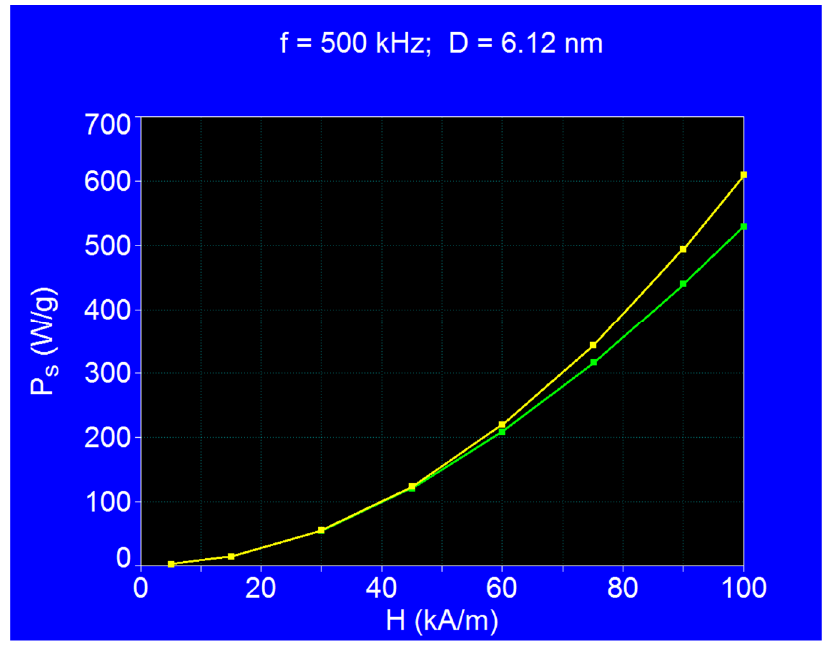
Figure 6. The dependence of the maximum specific loss power (P sM ) on the magnetic field (H) for CoFe 2 O 4 nanoparticles, calculated at the frequency (f) of 500 kHz using Equation (7) (yellow curve) and Equation (2) (green curve). and Equation (2) (green